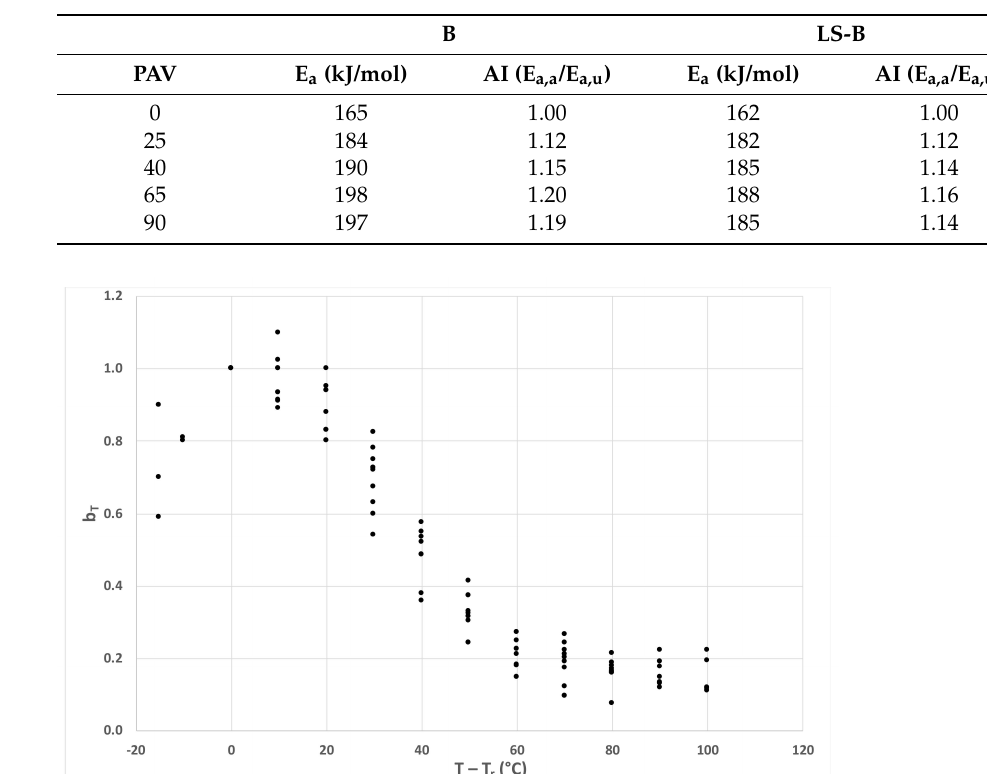
Table 2. Activation energies (kJ/mol).